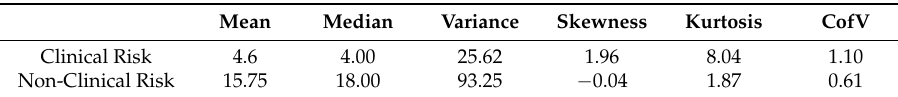
Table 1. Descriptive statistics of frequency.